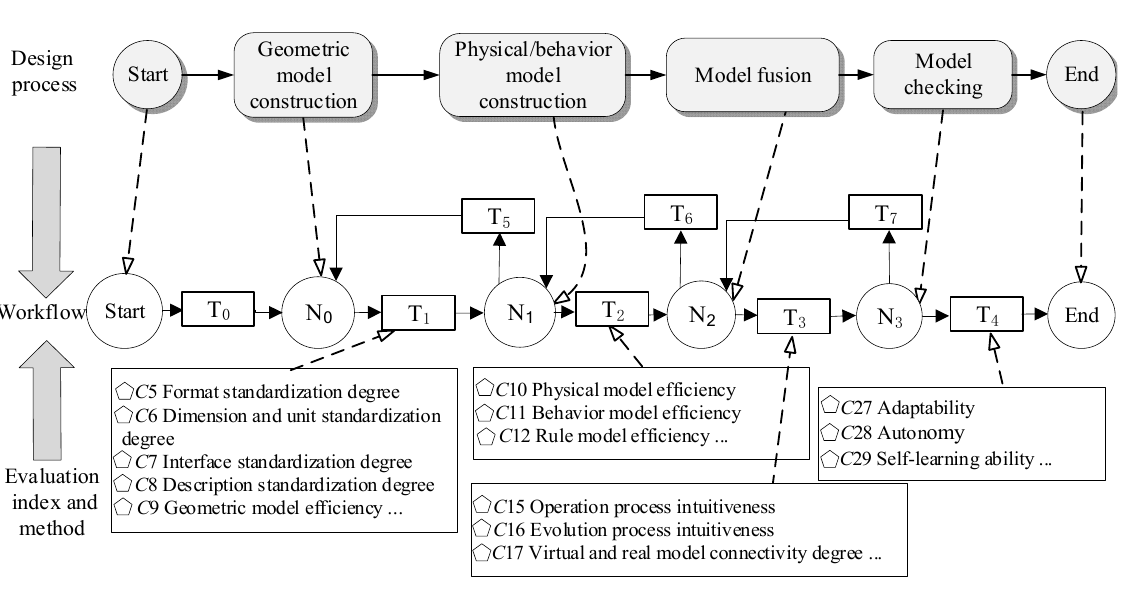
( b ) Figure 7. Multifunctional lift-and-slide experimental line: ( a ) physical entities ( b ) digital twin mod- els.